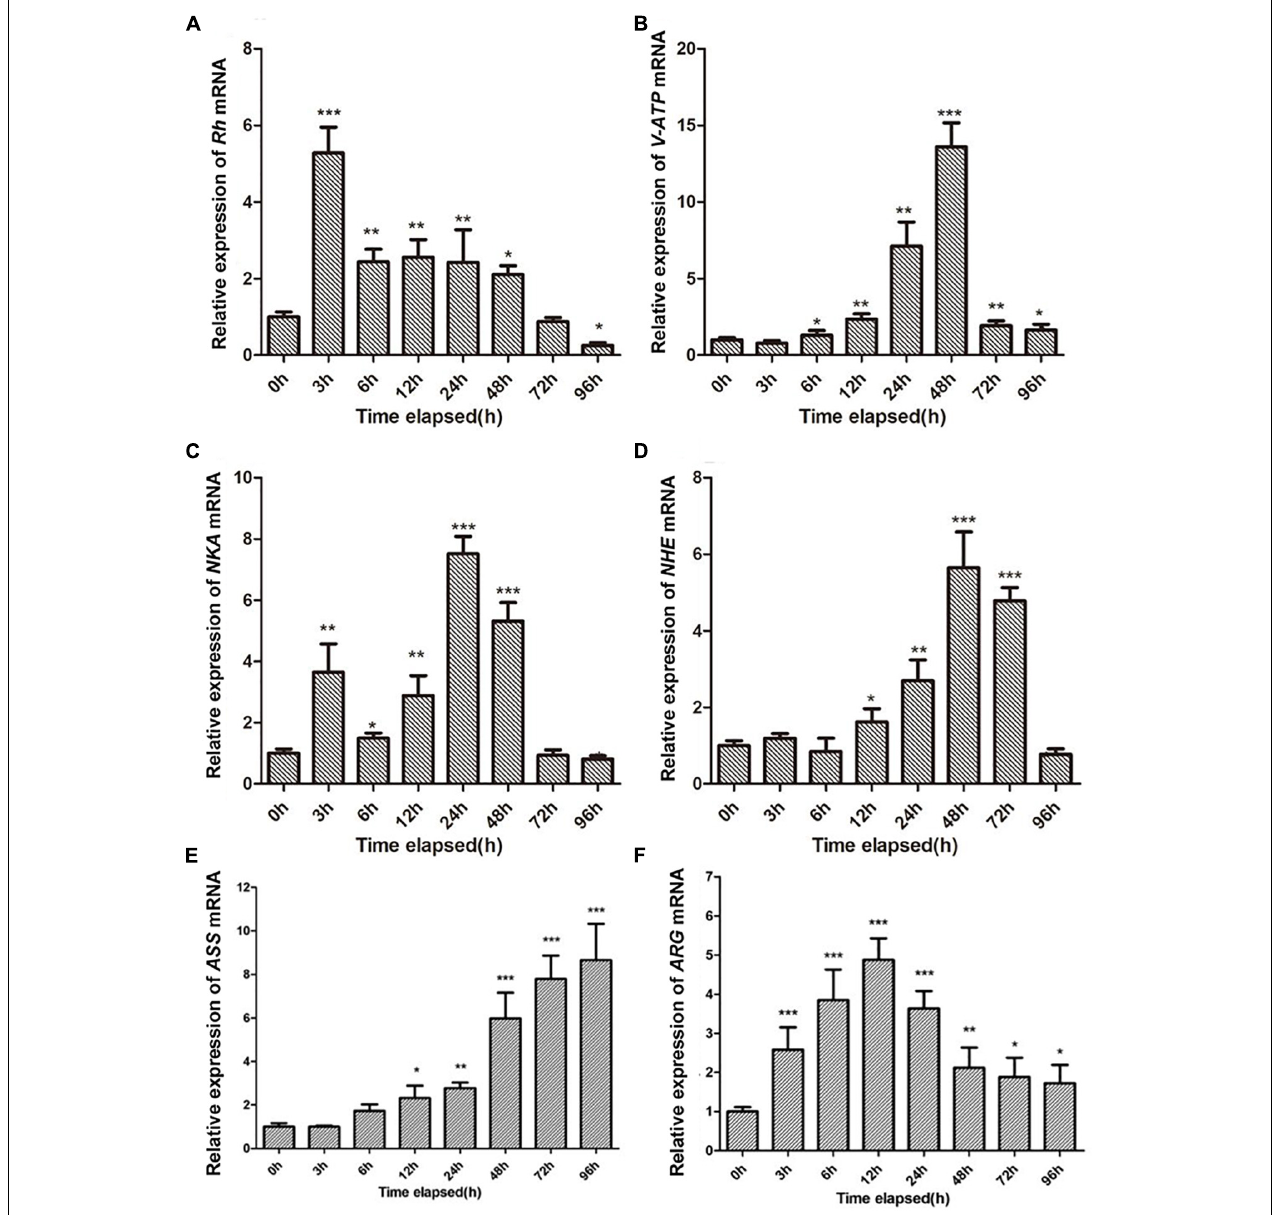
FIGURE 3 | Validation of RNA-seq profiles by qRT-PCR. (A–D) Represent the expression patterns of Rh , NKA , V-ATP , and NHE genes in the gill of S . constricta after exposure to 180 mg/L ammonia for 96 h, respectively. (E,F) Panels represent the expression patterns of the ARG and ASS genes in the hepatopancreas after exposure to 180 mg/L ammonia for 96 h, respectively. Vertical bars represent the mean ± SD ( n = 4). Asterisk (*) indicates a significant difference between the exposed shellfish and its respective control (* p < 0.05; ** p < 0.01; *** p <